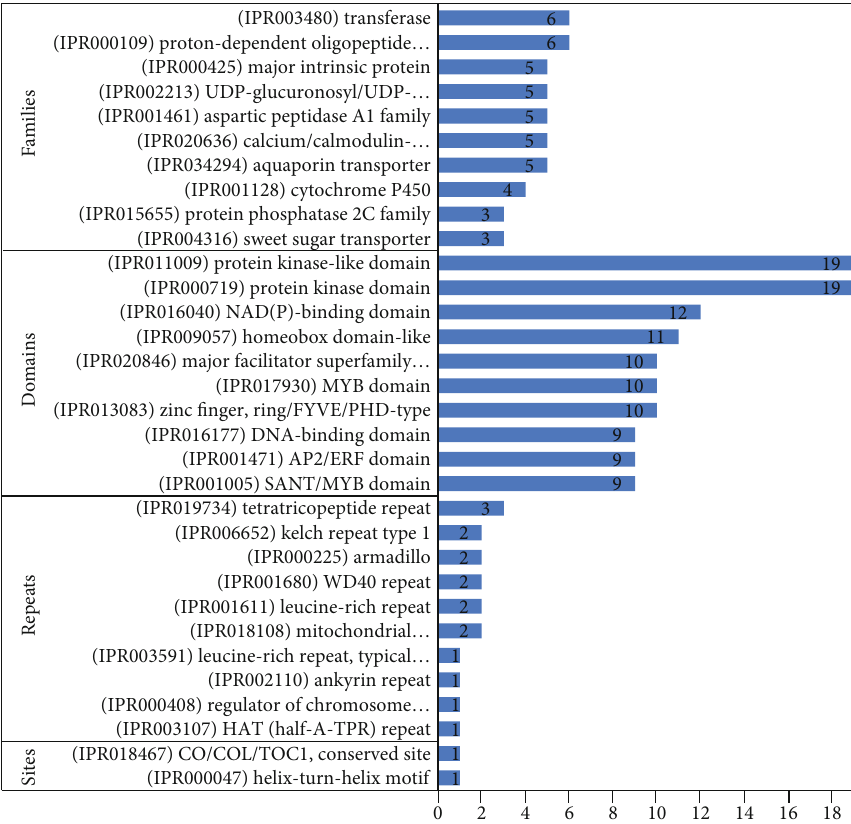
Figure 1: Top 10 upregulated families, domains, repeats, and sites under drought